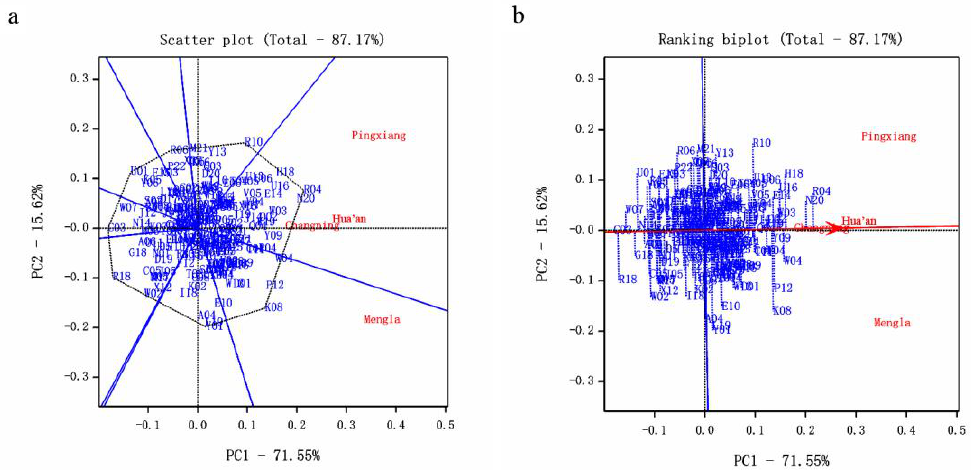
Figure 4. Biplot analysis based on CW data of 199 families. ( a ) Polygon view of GGE Biplot – which is best for what, ( b ) genotypes of ranking provenances. A, Mengla; B, Yuanyang; C, Mojiang; D, Jinghong; E, Xichou; F, Zhenyuan; G, Tengchong; H, Jinggu; I, Ruili; J, Fengqing; K, Pingbian; L,